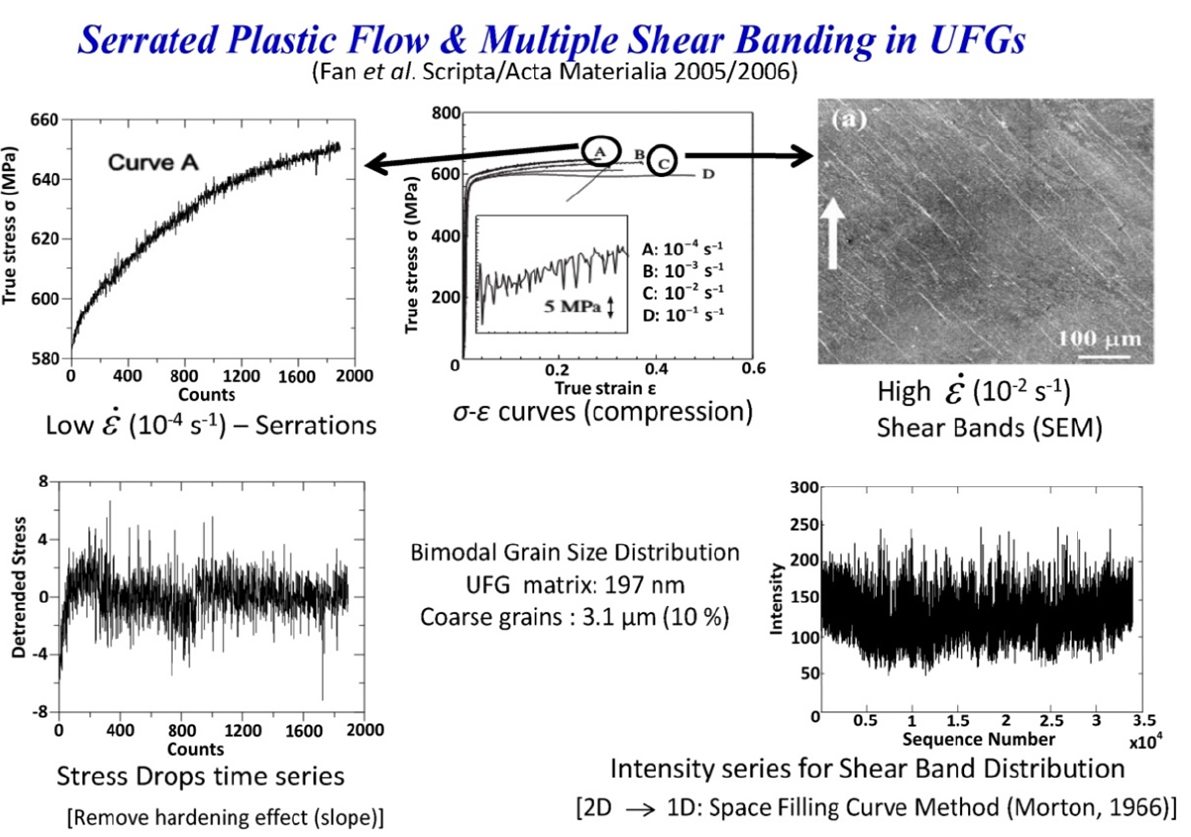
Figure 6: Serrated stress-strain curves, corresponding to electron micrograph images of shear band formation and respective time series analyses. For related details the reader can consult [7] and references quoted